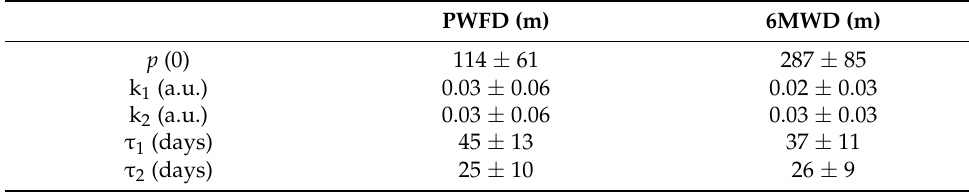
Table 4. Model parameters including baseline performance (p(0)) and constants.